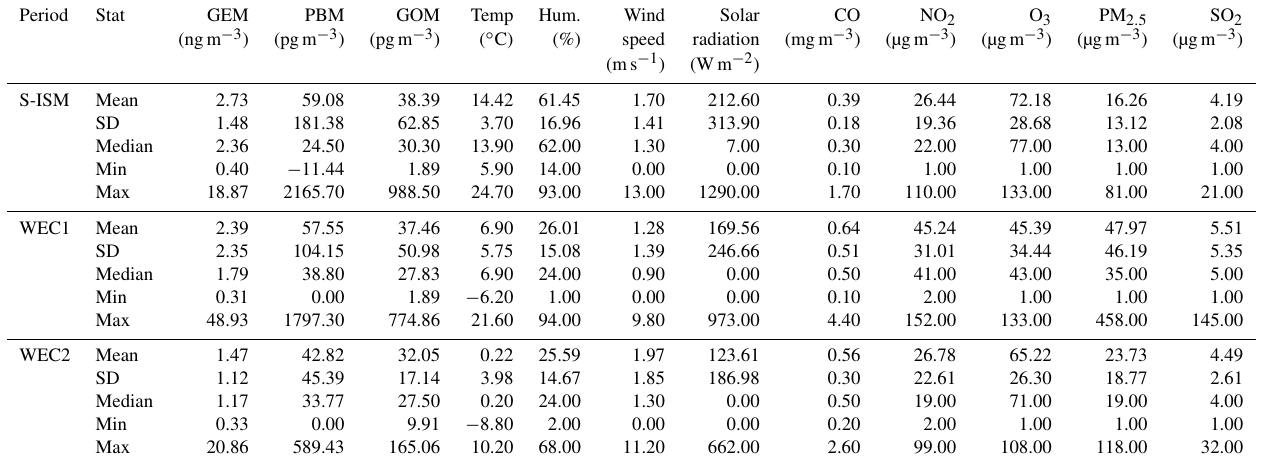
Table 1. Statistics metrics of species Hg, meteorological factors, and other